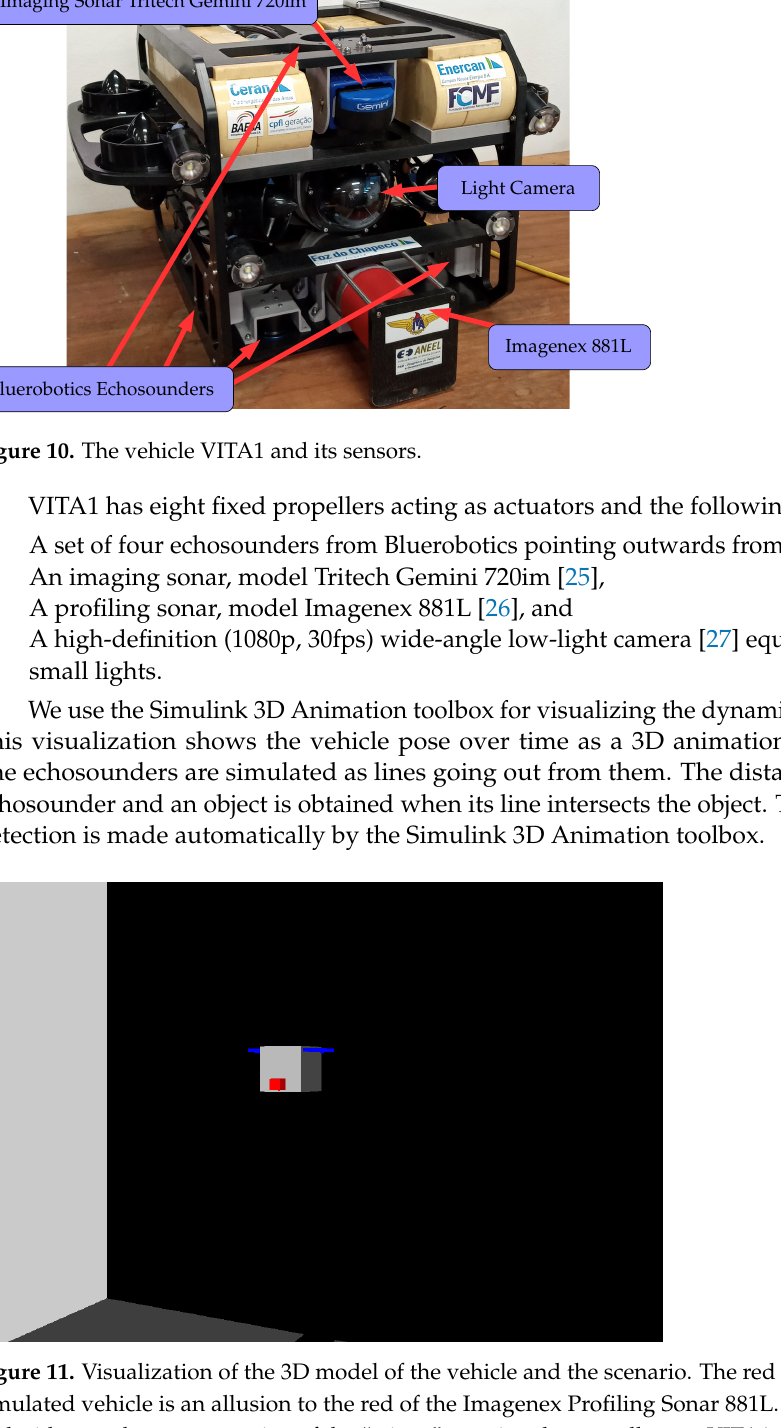
Figure 9. Logic connection of all three modules and their input and output signals.